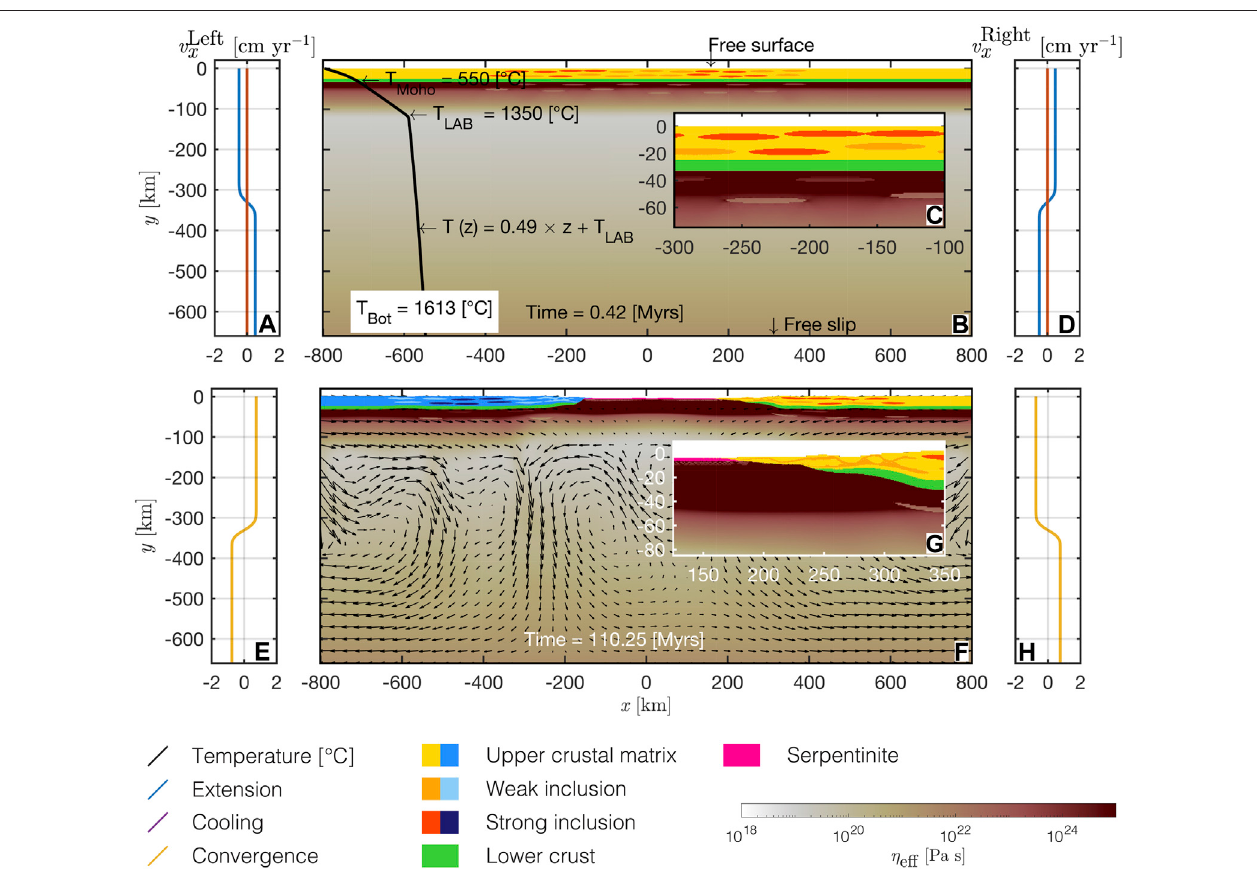
FIGURE 2 | Initial model con fi guration. Numerical resolution is 1 km by 1 km everywhere in the domain. (A – D) From the onset of rifting as modelled in detail by Candioti et al. (2021) and (E – H) from the onset of convergence as investigated in this study. (A,E) : vertical pro fi le of horizontal boundary velocity applied along the left boundary. (D,H) : vertical pro fi le of horizontal velocity applied along the right model boundary. (B,F) show the entire model domain. White to red indicates the effective viscositycalculatedbynumericalalgorithm,blacksolidlineistheinitialtemperaturepro fi le,lighttodarkorangeareupper crustallithologiesoftherightplate,lightto dark blue are the lithologies of the left plate, green is the lower crust of both plates and magenta is a serpentinite layer, initially 3 km thin. (C) : enlargement of the domain center and (G) shows an enlargement of the right margin. Glyphs in (F) show the velocity fi eld calculated by the numerical algorithm.